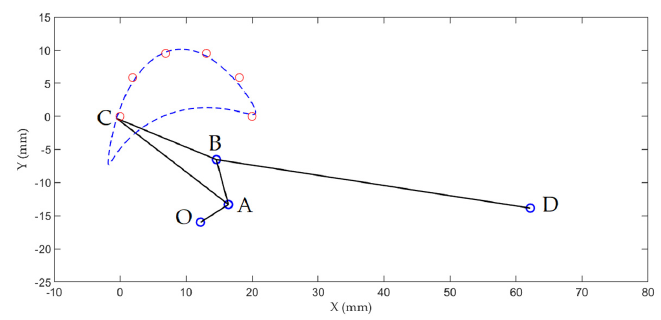
Figure 15. Trajectory of the coupler point of Case 3.